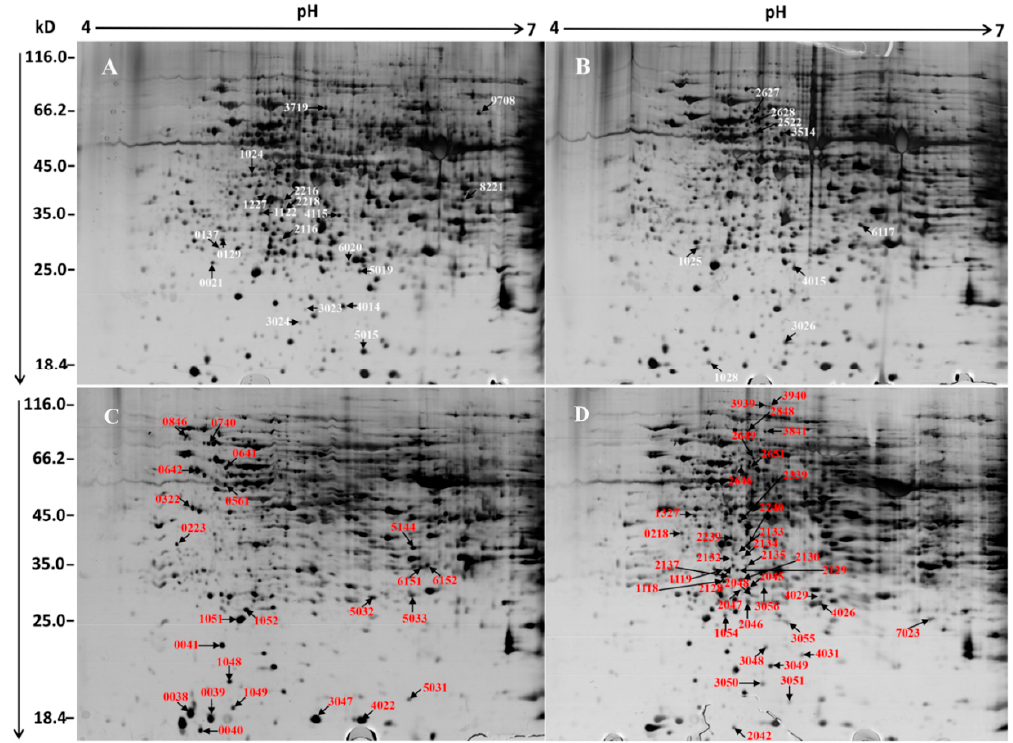
Figure 2. Representative 2-DE profiles of proteins in G. biloba . The molecular mass (M r ) in kDa and pI of proteins are indicated on the left and top, respectively. The identified proteins are annotated by a number and arrow. ( A ) Total proteins from YL; ( B ) Total proteins from GL; ( C ) Chloroplast proteins from YL; ( D ) Chloroplast proteins from GL. The arrows indicate increased protein spots in ginkgo.